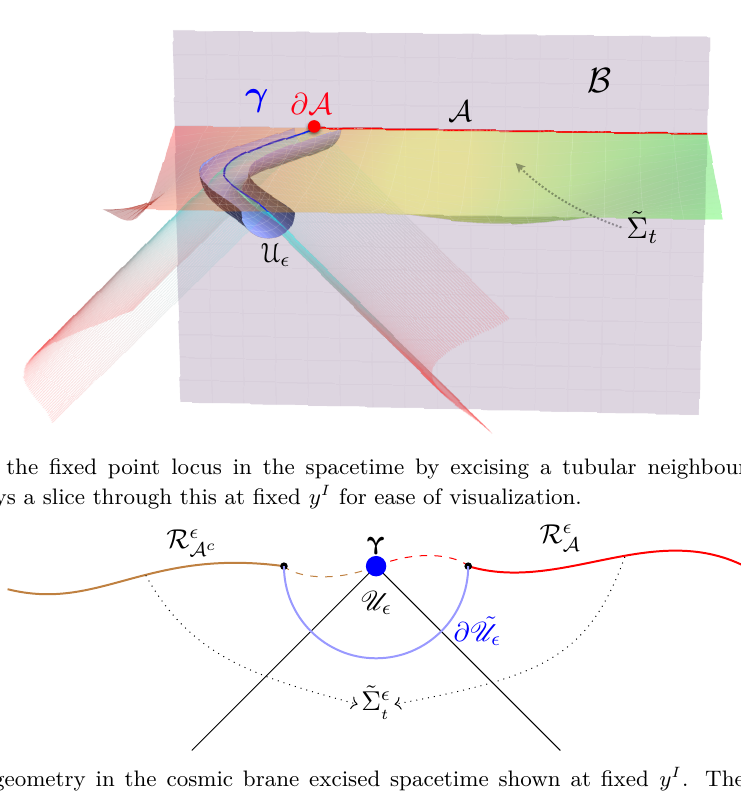
which is obtained from M k (cid:15)